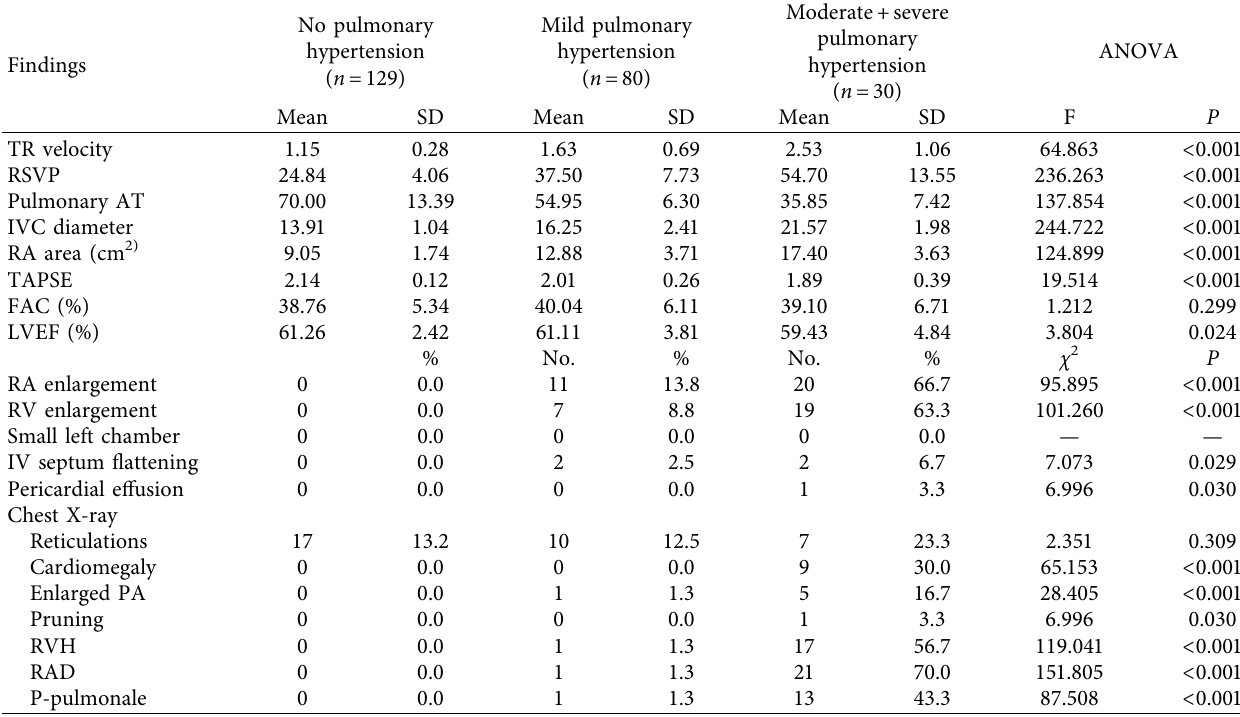
Table 8: Association of pulmonary hypertension ( ≥ 20 mmHg) and 2D echo findings, ECG, and X-ray findings. Findings